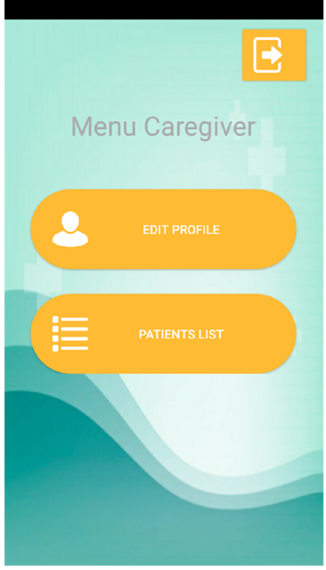
Figure 7. Caregiver’s Menu.